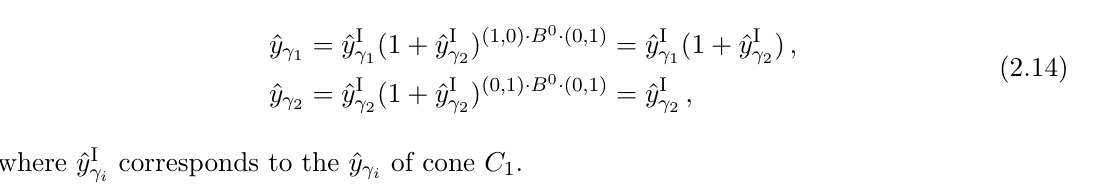
Figure 4. Two examples of scattering diagrams. The scattering diagram on the left is inconsistent if B 0 equals eq. (2.13). The relations between ˆ y i,j The scattering diagram on the right is path-independent and can be identified with the A ter